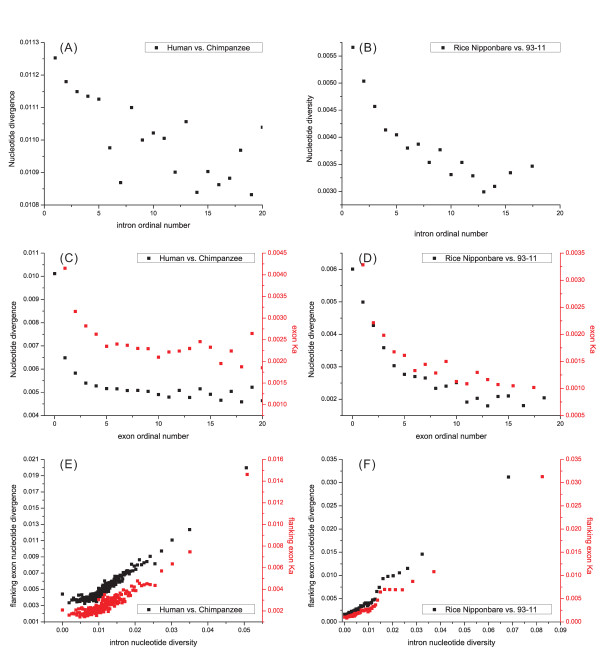
Correlation between nucleotide divergence (or exon's Ka) and ordinal position of introns (A & B) or of exons (C & D) and between intron and flanking exon divergence (or Ka) (E & F). The left panel shows the results from the comparison between human and chimpanzee, and the right panel shows the comparison between two rice lines.